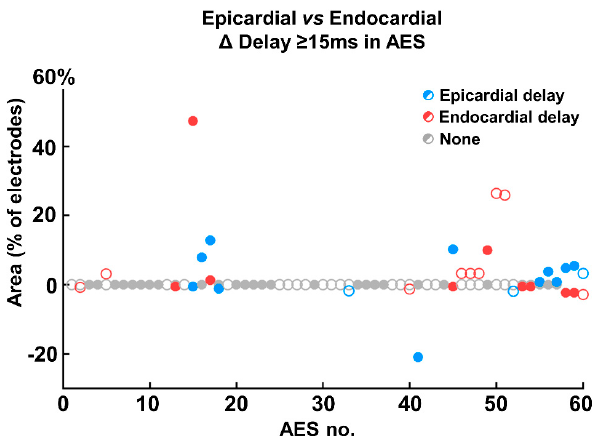
Figure 4. Scatterplot presenting the amount of decrease or increase of endocardial and epicardial delays ≥ 15 ms per atrial extrasystole (AES) compared to sinus rhythm. Multiple AES in one patient are clustered and a change from an open to a filled marker represents a different patient. For example, in the 8th patient the first AES has a 47% increase in endocardial delays and an 0.5% decrease in epicardial delays. The second AES in this patient demonstrates a 7.8% increase in epicardial delay and no change in endocardial delay J. Clin. Med. 2020 , 9 , x FOR PEER REVIEW